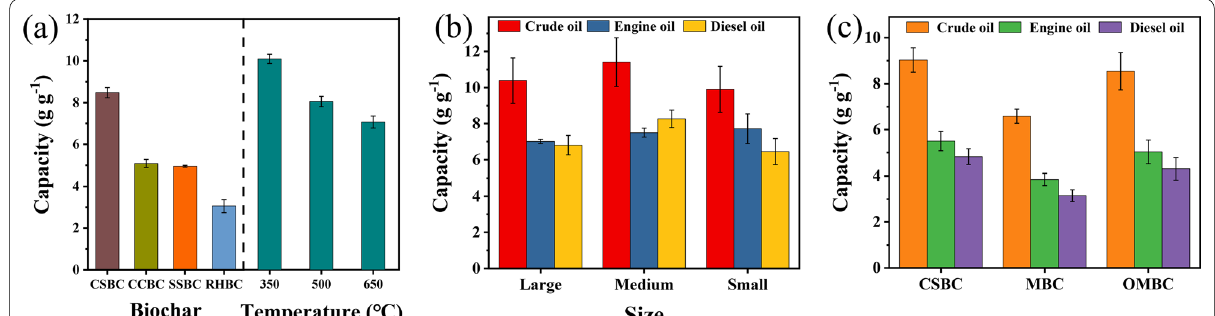
Fig. 6 The oil capacity of biochar and modified biochar. The crude oil sorption capacity of biochar that pyrolyzed from various feedstock materials prepared at 500 ℃ and the corn stock biochar that was pyrolyzed at different temperatures ( a ). The sorption capacity of different sizes of CSBC350 for three oils. (Small: 0.55–0.25 mm, Medium: 0.25–0.15 mm, and Large: < 0.15 mm) ( b ). The sorption capacities of CSBC (350 ℃ ), MBC, and OMBC for three types of oil in the oil–water system ( c